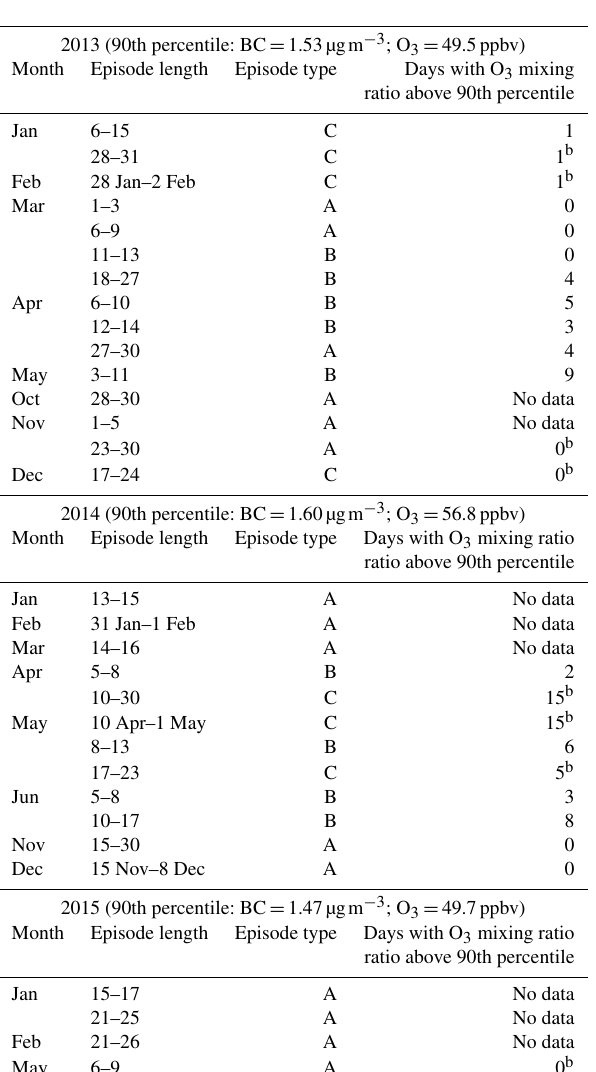
Table 2. List of enhanced BC episodes observed at JSM_STA and the concurring regional sources from